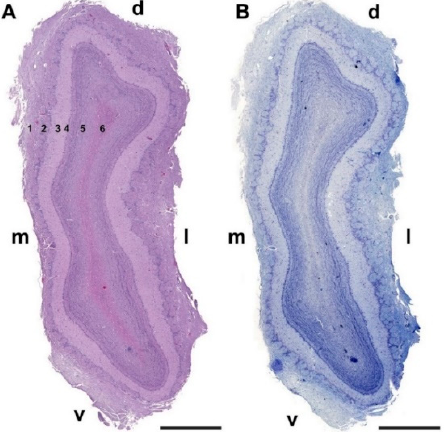
Figure 18. Transverse section of the olfactory bulb of the red fox stained by hematoxylin–eosin ( A ) and Nissl staining ( B ) From superficial to deep the following layers are identified: (1) Olfactory nerve layer (NL); (2) Glomerular layer (GlL); (3) External plexiform layer (EPL); (4) Mitral cell layer (ML); (5) Granular layer (GrL); (6) White matter: d, dorsal; l, lateral; m, medial; v, ventral. Scale bars: 2 mm.